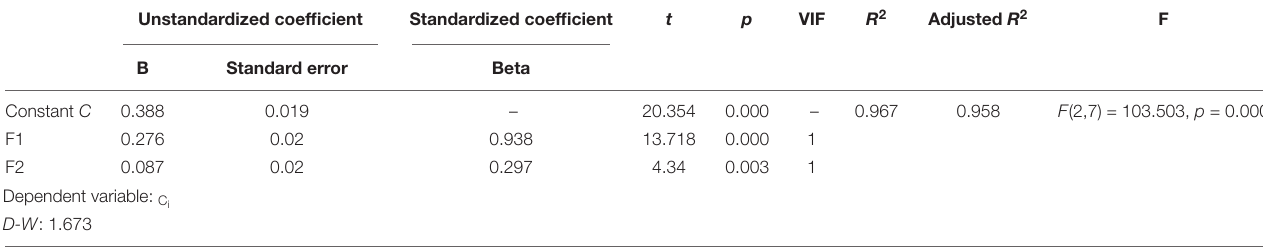
TABLE 10 | Results of stepwise regression analysis ( n =